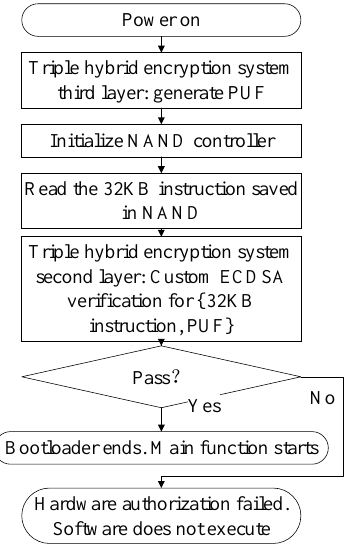
Figure 23. SoC software